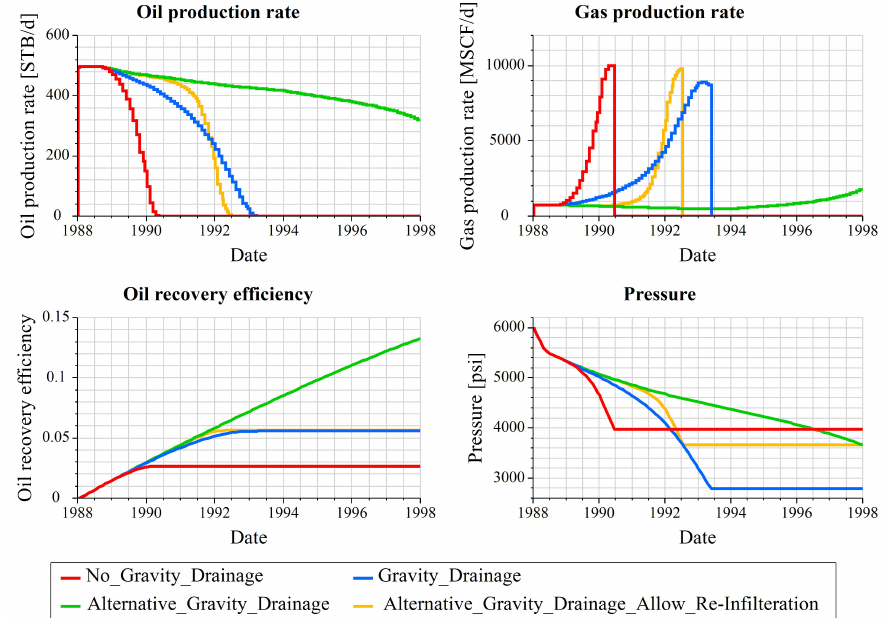
Figure 4. Comparison of the model behavior using different gravity drainage options, remarkable differences were observed in the results which highlight the significant roles of the gravity mechanisms. The results of the gravity drainage scenario (blue line legend) represent the published results of [30] work, where the data file is available in the ECLIPSE package with the name SPE 6_ FRAC